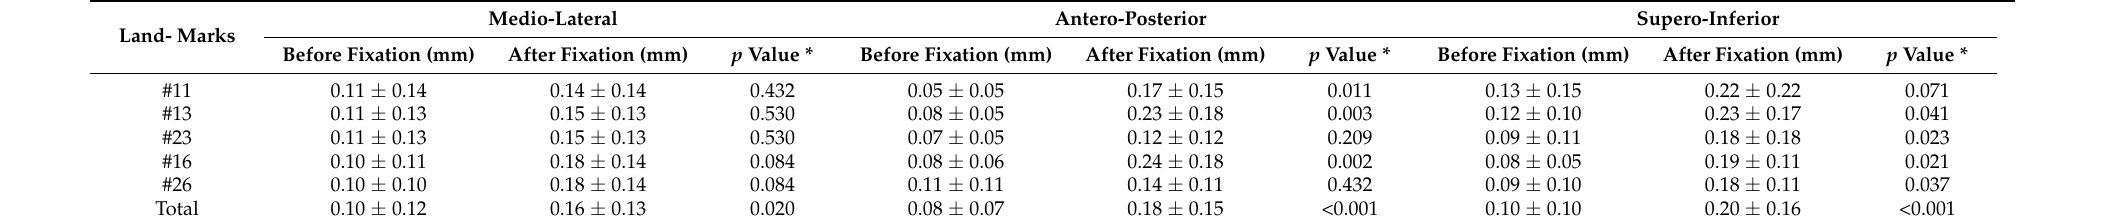
Table 2. Mean absolute deviation based on intraoperative navigation before and after maxillary fixation.